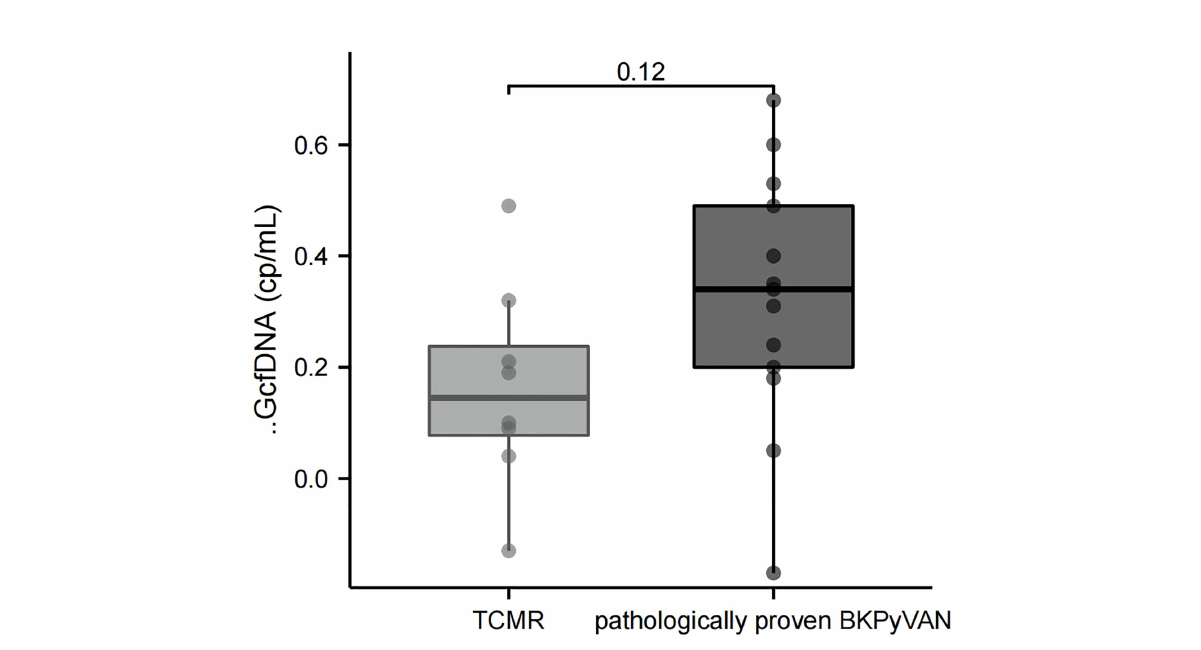
FIGURE 5 Comparison of D GcfDNA(cp/mL) between TCMR and pathologically proven BKPyVAN. BKPyVAN, BK polyomavirus-associated nephropathy; TCMR, T cell-mediated